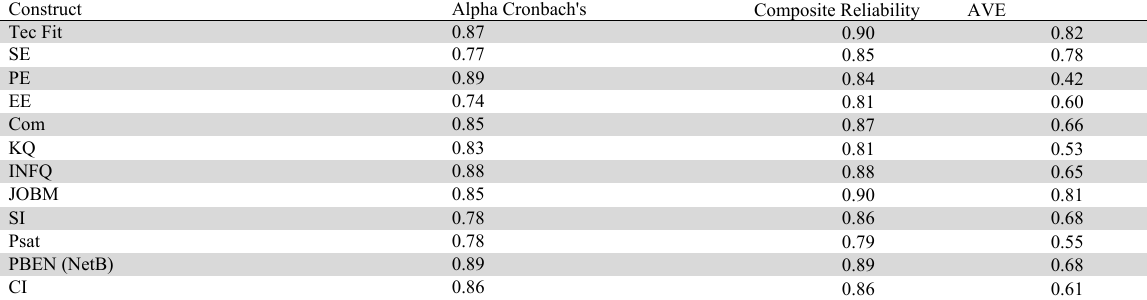
Reliability Statistics for the